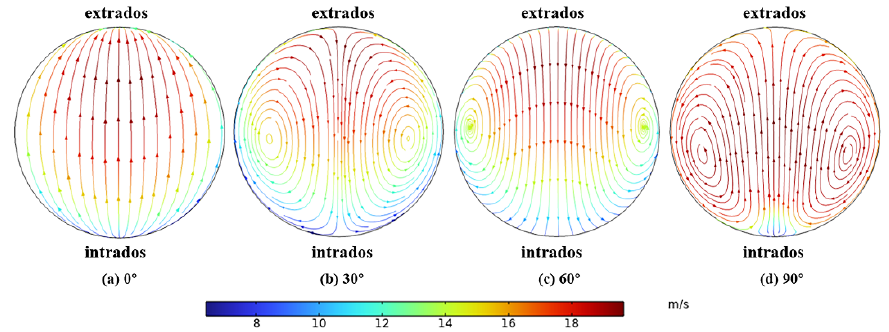
Figure 12. Section of axial 0° to 90° streamline development of elbow.